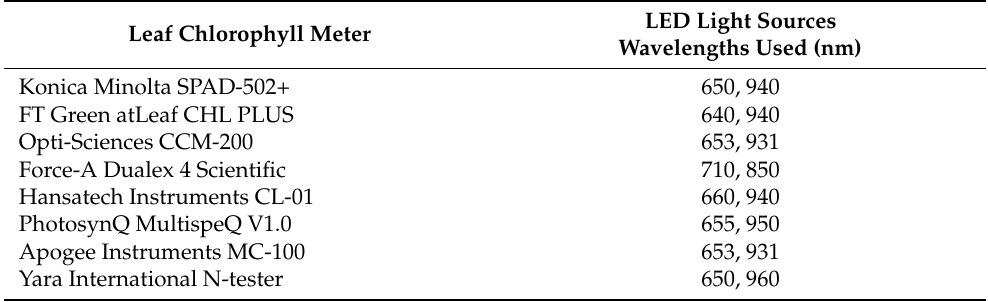
Table 1. Some of the transmittance-based hand-held optical chlorophyll sensors along with the wavelengths that they utilize for relative chlorophyll content